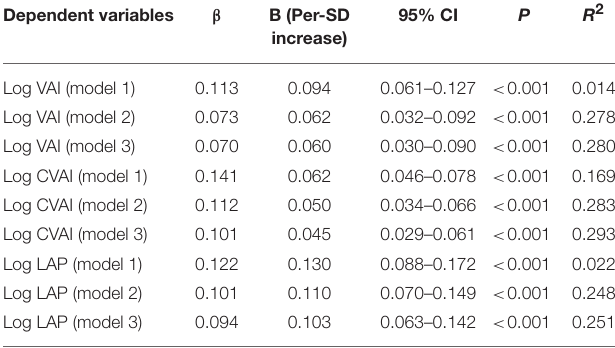
TABLE 3 | Association of LH/FSH ratio with visceral adiposity indicators: linear regression. Dependent variables